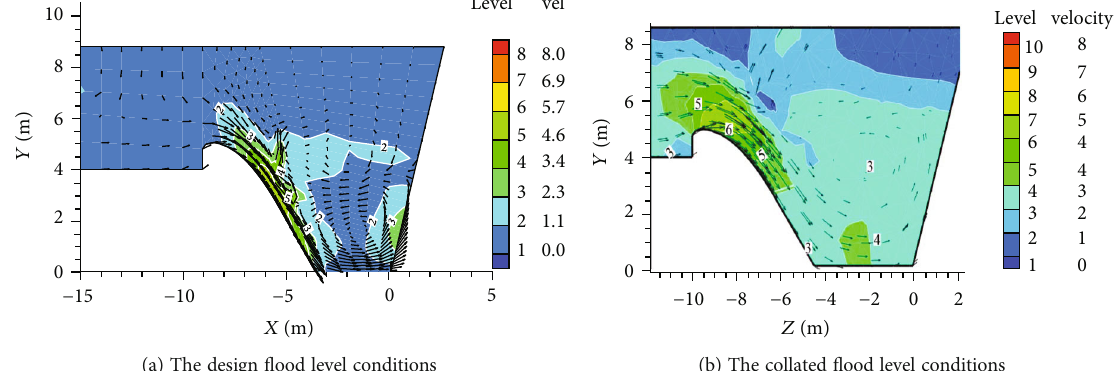
Figure 6: The fl ow velocity distribution in the cross section of